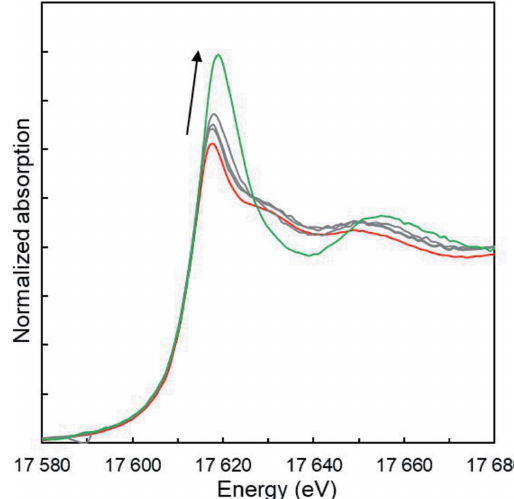
Figure 6 Normalized Np L 3 -edge XANES spectrum for the Np V reduction experiment at 750, 0, (cid:2) 100, (cid:2) 150, (cid:2) 200 and (cid:2) 250 mV/(Ag/AgCl).